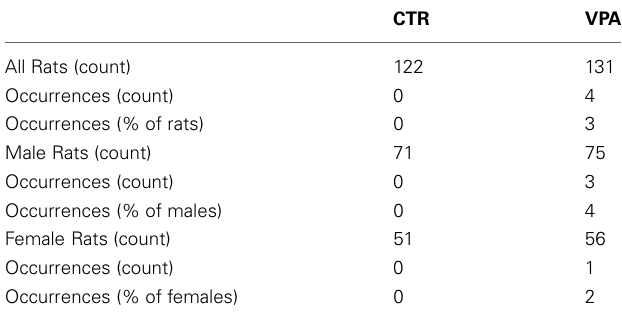
Table 3 | Offspring